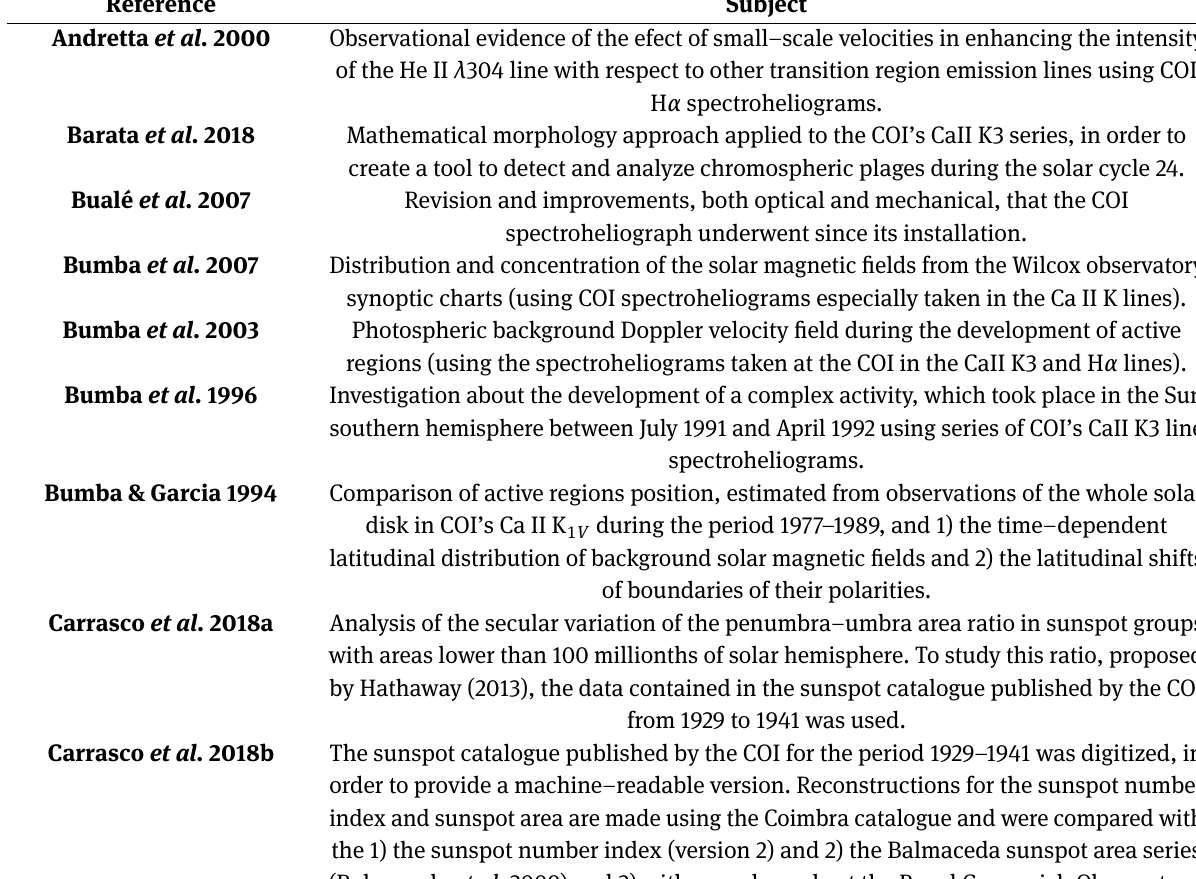
Table 2. International scientific collaborations with the Geophysical and Astronomical Observatory of the University of Coimbra, using data obtained by the